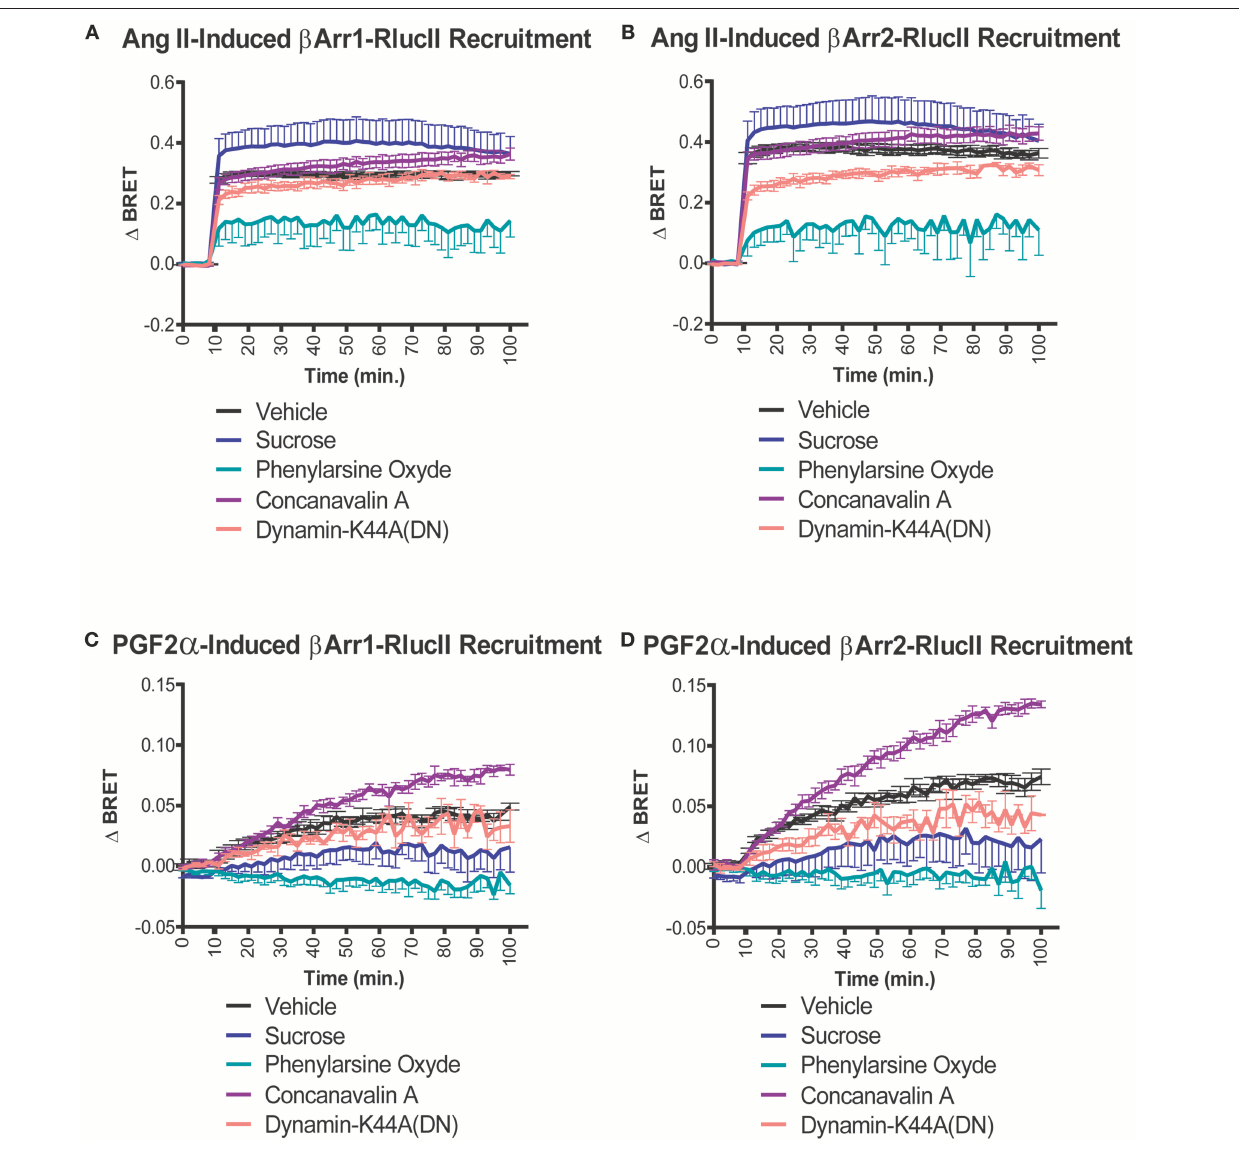
FIGURE 6 | Effects of endocytosis inhibitors on Ang II- and PGF2 α -induced β -arrestin 1/2 recruitment to the AT1R/FP dimer. (A,B) Sucrose (blue lines, 450mM) and phenylarsine oxide (blue-green lines, 2.5 µ M) pretreatment (30min) potentiated and diminished the recruitment of β -arrestin1/2-RlucII to the AT1R-Venus/FP-WT dimer in response to Ang II (1 µ M), respectively. To a much lesser extent, concanavalin A (purple lines, 0.4 g/L) pretreatment (30min) and the dominant negative mutant K44A dynamic (salmon lines; 0.5 µ g) also potentiated and diminished the responses, respectively. (C,D) Concanavalin A (purple lines, 0.4 g/L) and phenylarsine oxide (blue-green lines, 2.5 µ M) pretreatment (30min) potentiated and diminished the recruitments of β -arrestin 1/2-RlucII to the AT1R-Venus/FP-WT dimer in response to PGF 2 α (1 µ M), respectively. To a lower extent, sucrose (blue lines, 450mM) and the dominant negative mutant K44A of dynamin (salmon lines; 0.5 µ g) both diminished the responses. Data represent mean ± s.e.m. of independent experiments performed in triplicate ( n = 3–4). (1), and leukotriene B4 receptor dimers (35). These